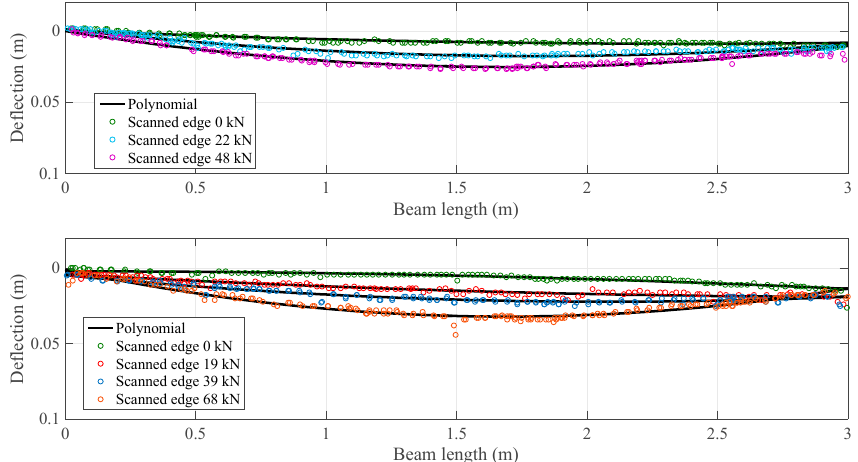
Figure 13. CRP polynomials fitted along beam span for beam#1 LC2 ( top ) and beam#2 ( bottom ). The rounded markers represent a selection of the mesh points used in the fitting process.